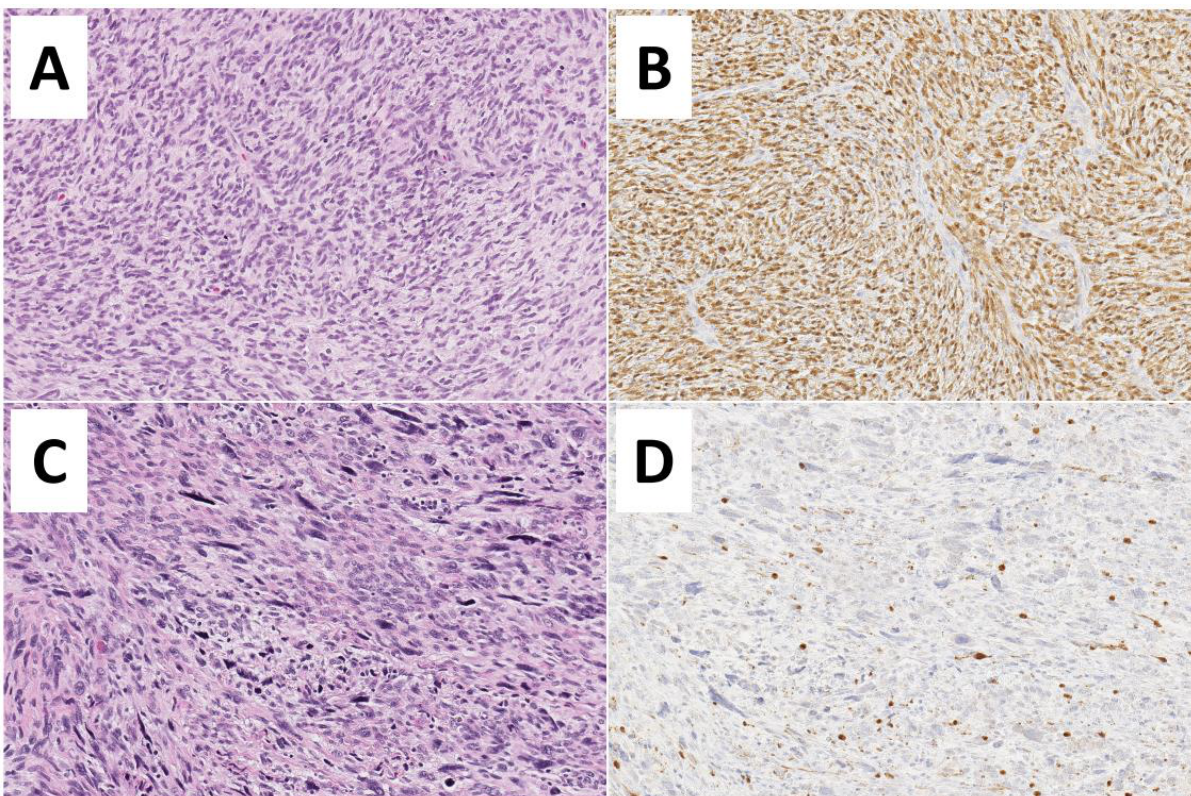
Figure 2. Histopathological features of Malignant Peripheral Nerve Sheath Tumors — MPNSTs. ( A , B ) Low-grade MPNST composed of a spindle cell proliferation with increased cellularity, mild cytological atypia, few mitoses (3 to 9 mitoses per 10 high-power fields), but no evidence of necrosis (Hematoxylin and Eosin, 200x). Diffuse immunoreactivity for S100-protein is noted (200x). ( C , D ) High-grade MPNST showing marked hypercellularity, nuclear pleomorphism, necrosis, and numerous mitoses (more than 10 mitoses per 10 high-power fields) (Hematoxylin and Eosin, 200x). Only focal S100-protein positivity is observed.